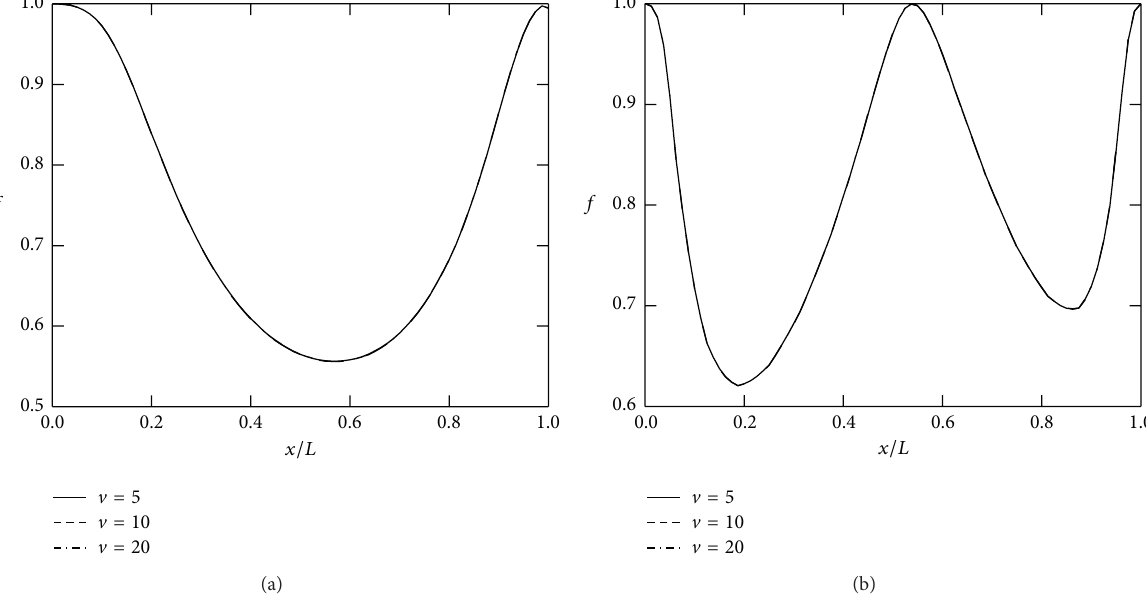
Figure 6: The first two normalized natural frequencies of clamped-simple Timoshenko beam subjected to a moving mass with different